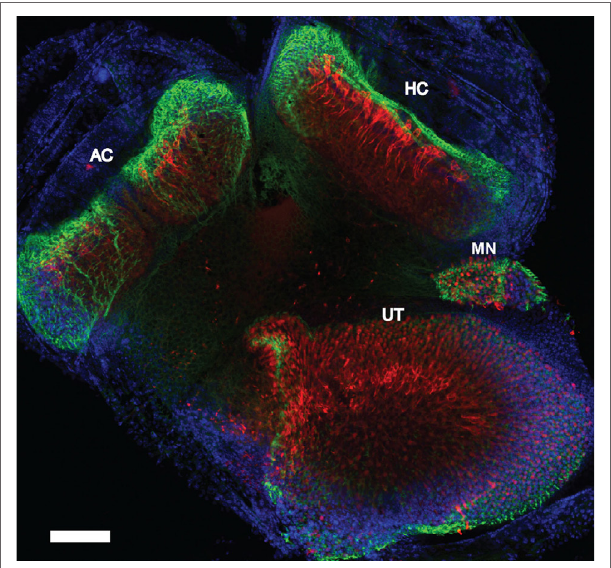
FigUre 7 | Whole mount immunofluorescence of the vestibular receptor organs. Vestibular receptor organs in a control mouse were labeled with phalloidin (green), calretinin (red), and DAPI (blue). Horizontal semicircular cristae (HC), anterior semicircular cristae (AC), utricle (UT), and macula neglecta (MN). Scale bar = 200 µm.